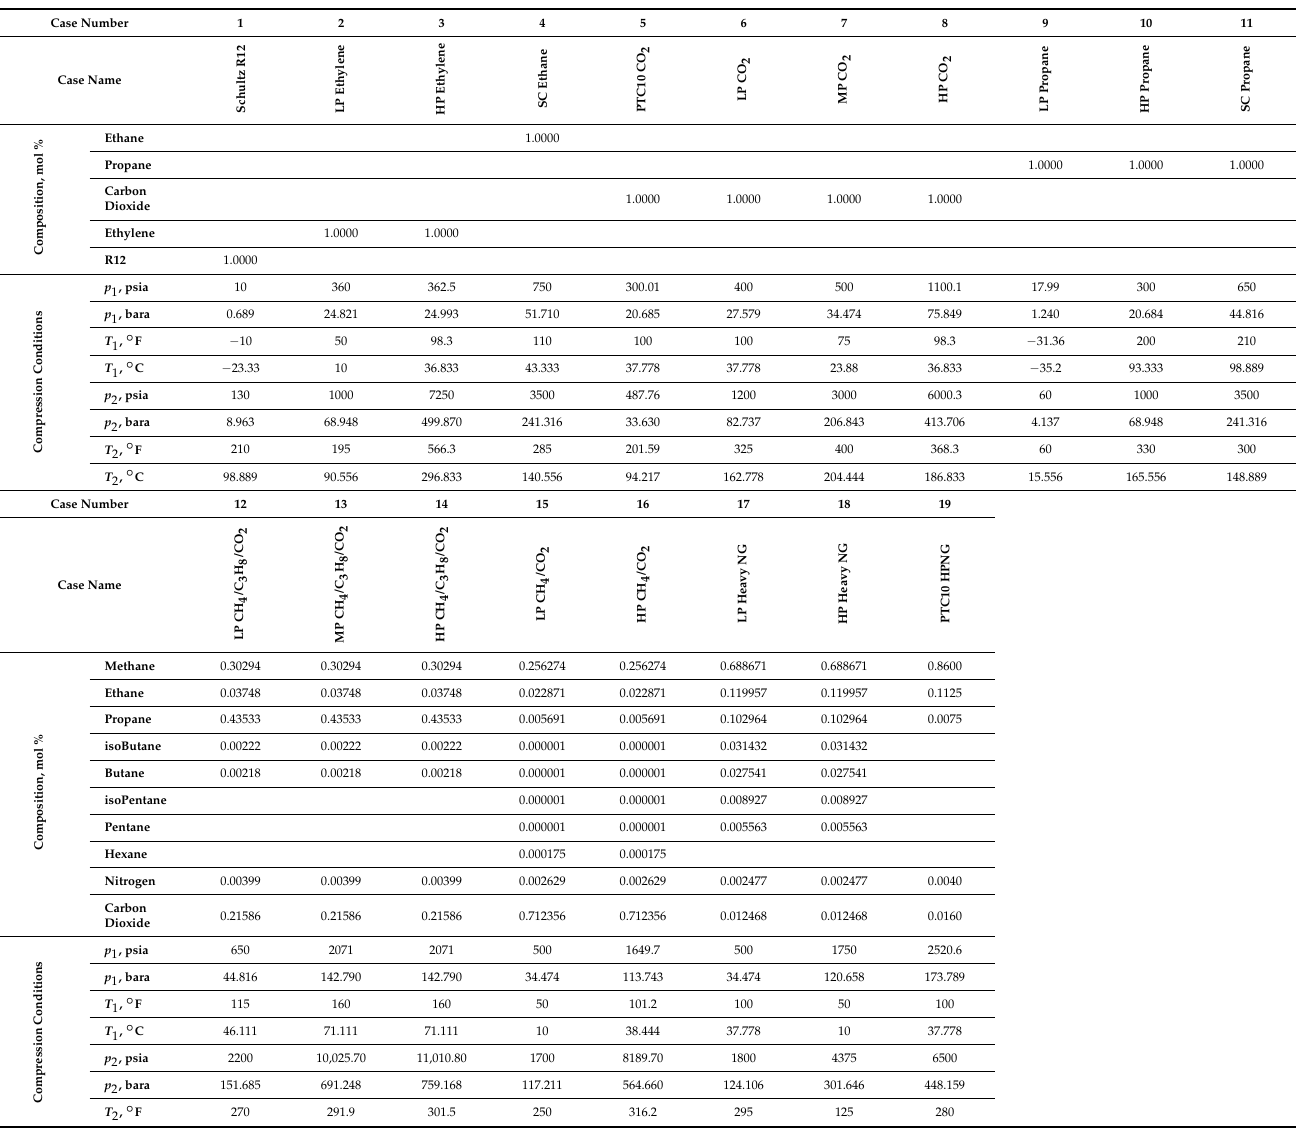
Table A1. Example case input